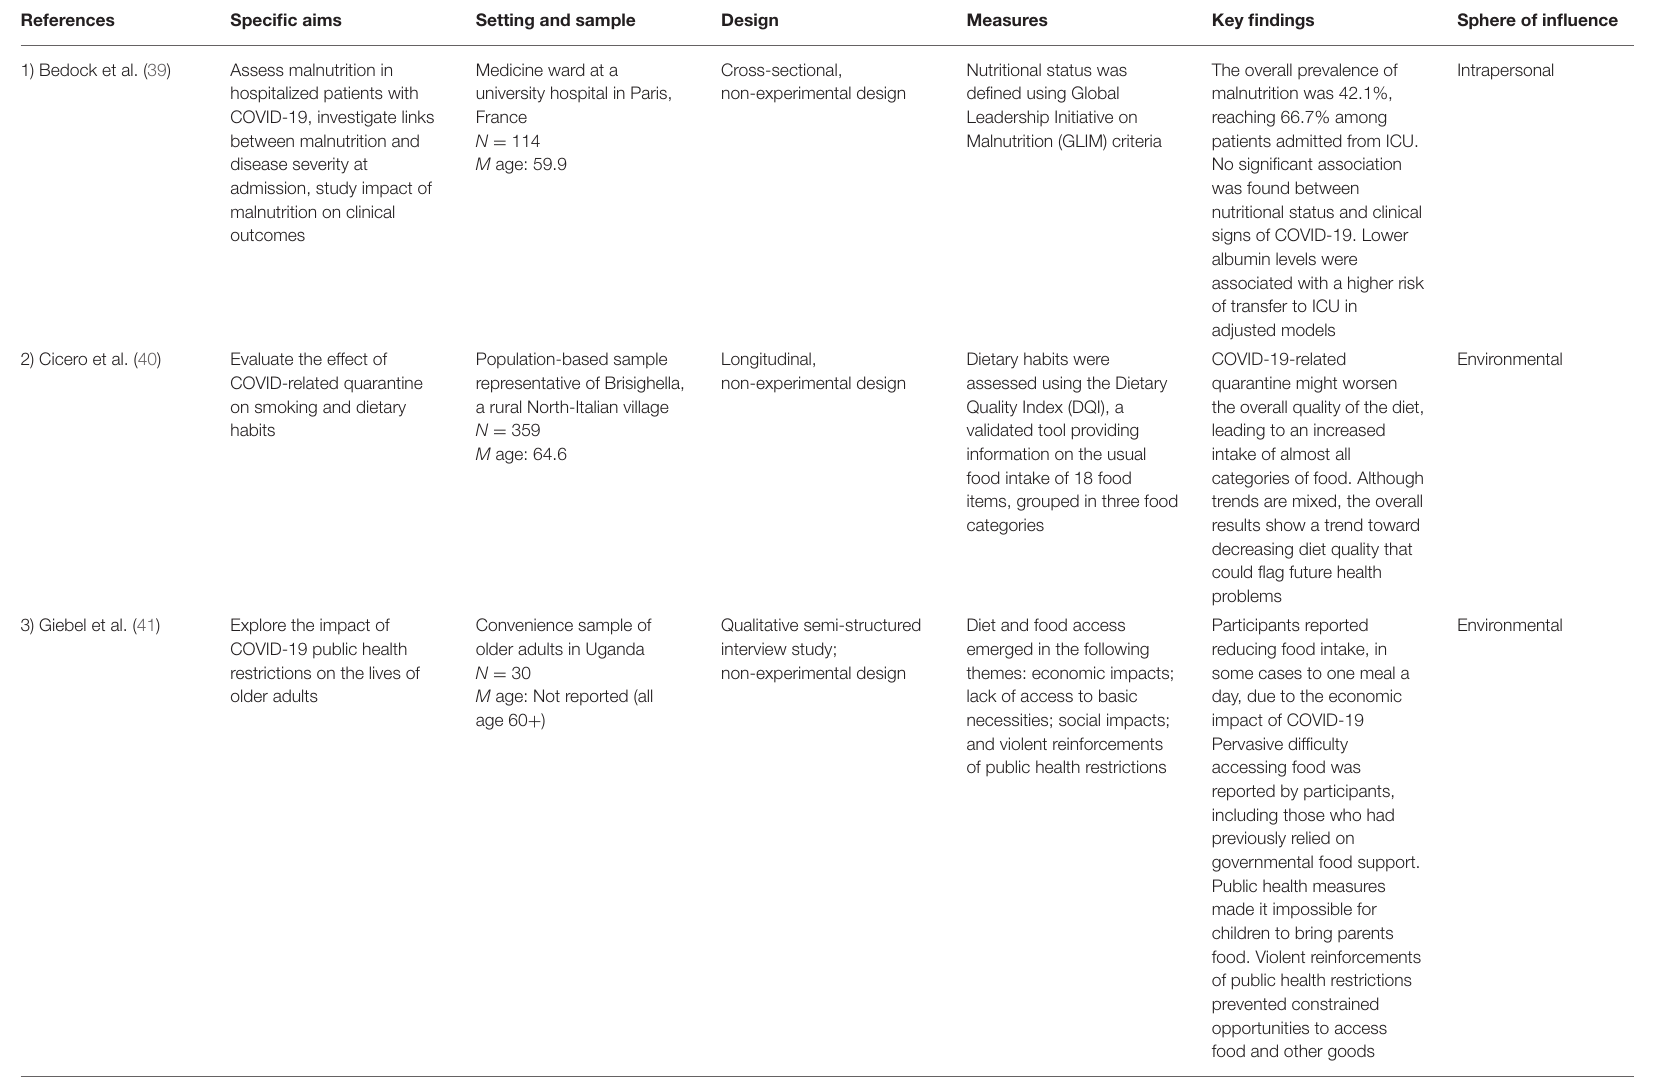
TABLE 1 | Characteristics of studies examining food access, diet quality, and nutrition among older adults during